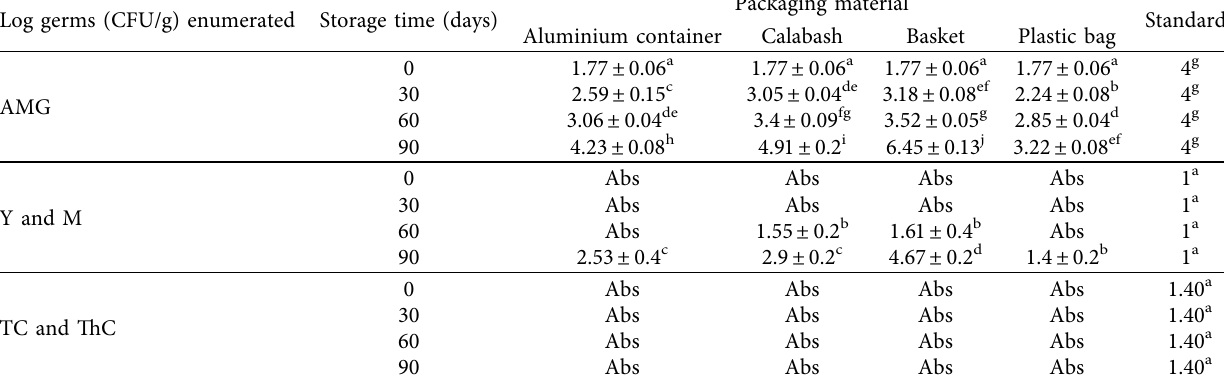
Table 2: Microbial flora of P. butyracea butter during storage in different packaging materials ( n � 6).